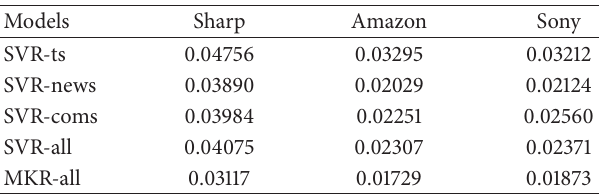
Table 12: Average of RMSEs in the five out-of-sample testing periods for three-stock price